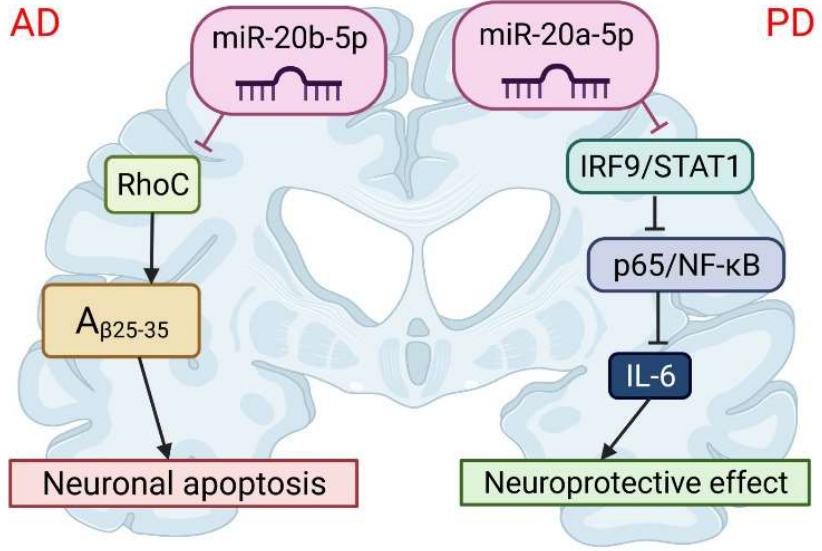
Figure 5. The role of miR-20 in the pathophysiology of neurodegenerative diseases. miR-20b-5p could disrupt Alzheimer’s disease progression by regulating neuronal apoptosis and cell viability by targeting the RhoC gene. miR-20a-5p has a protective effect on Parkinson’s disease-related neuronal death, which can be achieved by targeting the IRF9/NF- κ B axis. This image was created using BioRender (accessed on 30 March 2022).